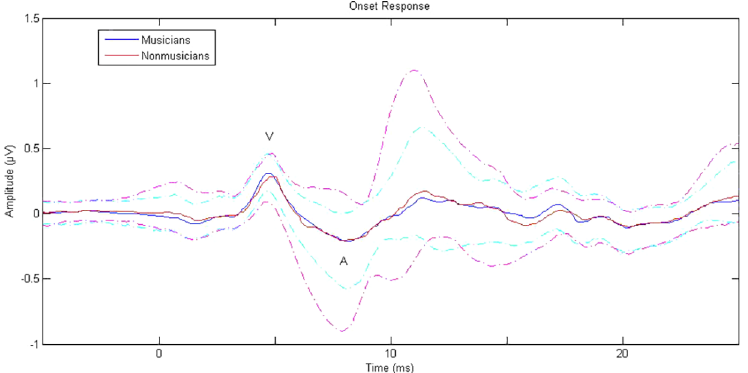
Fig 1. Onset response of musicians (blue, dark) and nonmusicians (red, light) to synthesized nonspeech sounds showing V-A complex. Dashedlines represent one standard deviation.